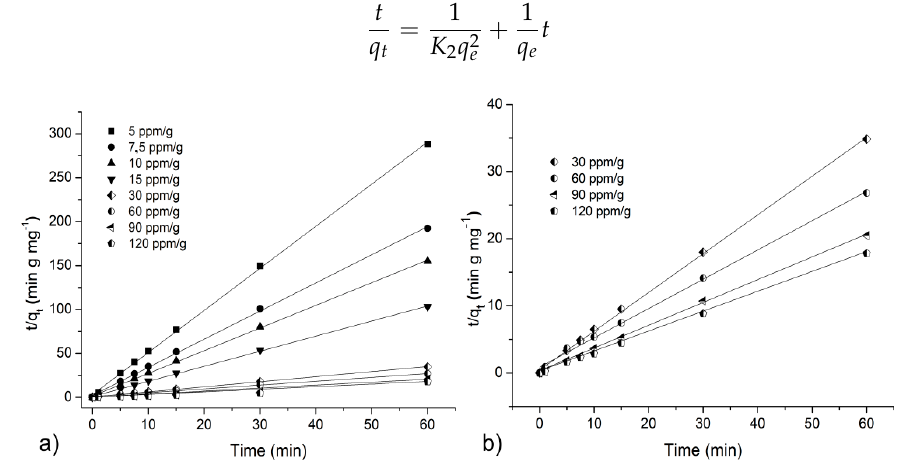
Figure 6. ( a ) Fitting of the experimental data by the pseudo-second order kinetics model. Experimental conditions: water volume = 50 mL; pH = 5. ( b ) Magnification of the data from 30 ppm/g to 120 ppm/g for a better visibility of the fitting. The errors in the t/ q t evaluations are in the range from 0.09 to 0.72%.